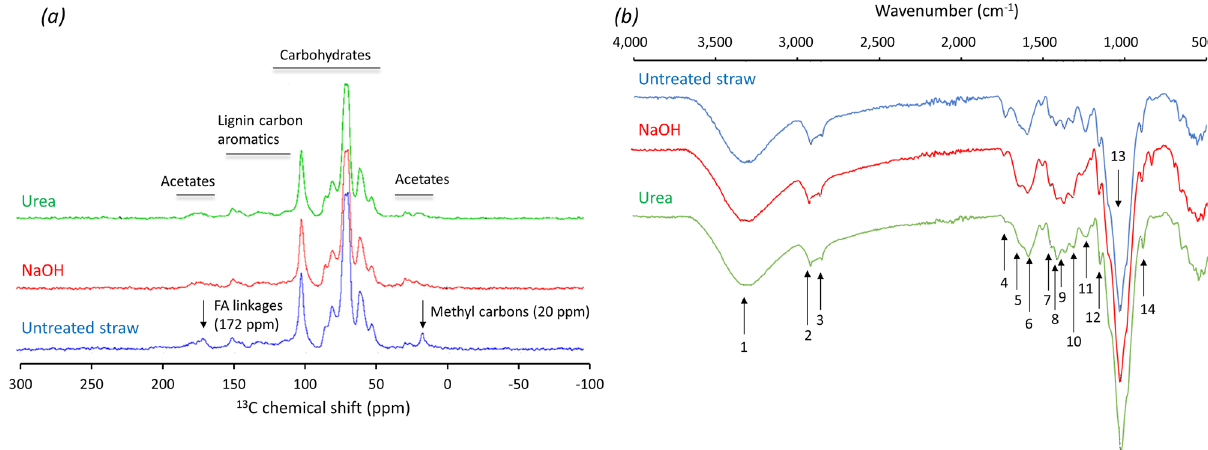
Figure 3. 13 C nuclear magnetic resonance (NMR) ( a ) and Fourier-transform infrared (FTIR) spectra ( b ) of untreated, NaOH treated, and urea treated barley straw. Straw treatments are specified in the text. The band assignments for FTIR spectra (peaks 1–14) are given in Table 7. FA, ferulic